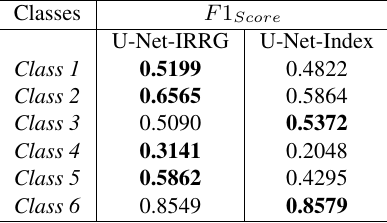
Table 4. Classes F 1 Score for baseline results over